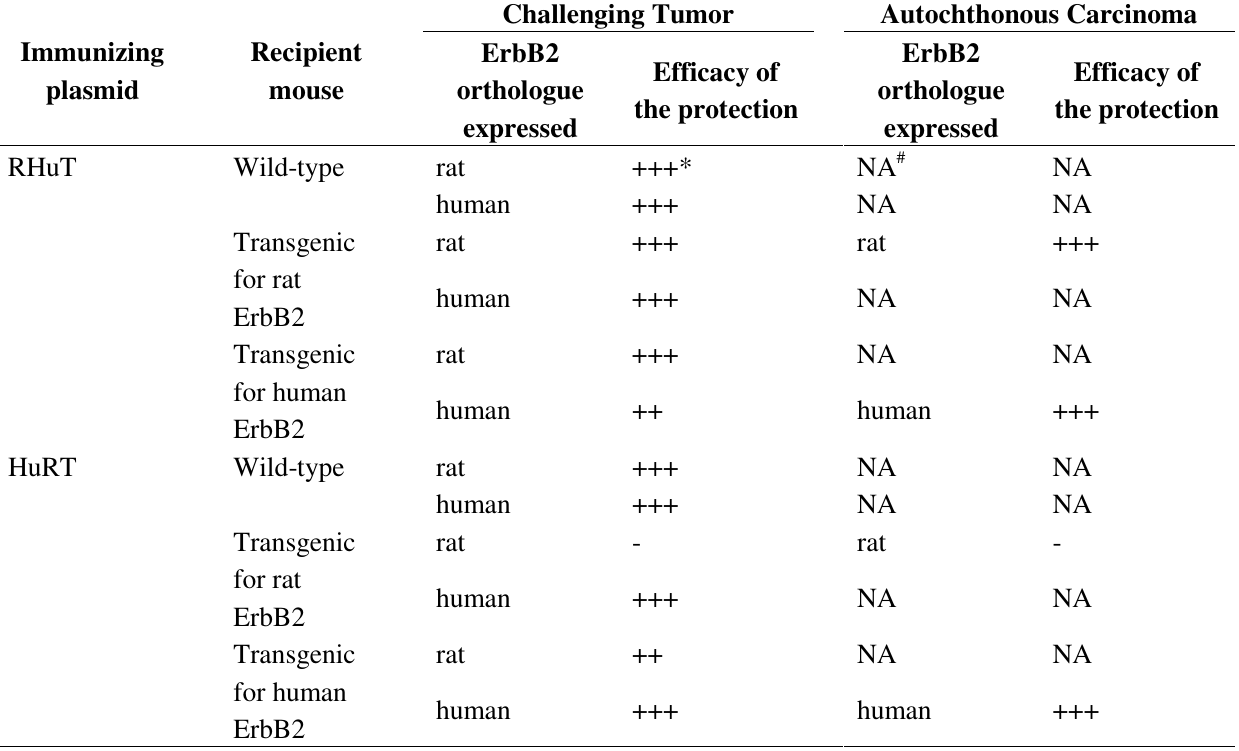
Table 2. ErbB2 orthologue restriction of the protection against tumor growth elicited by anti-ErbB2 DNA chimeric